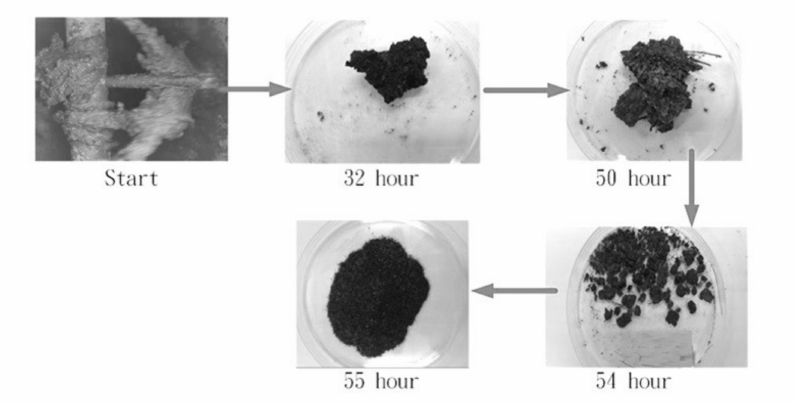
Figure 14. Chicken manure treatment results from start to 55 h.